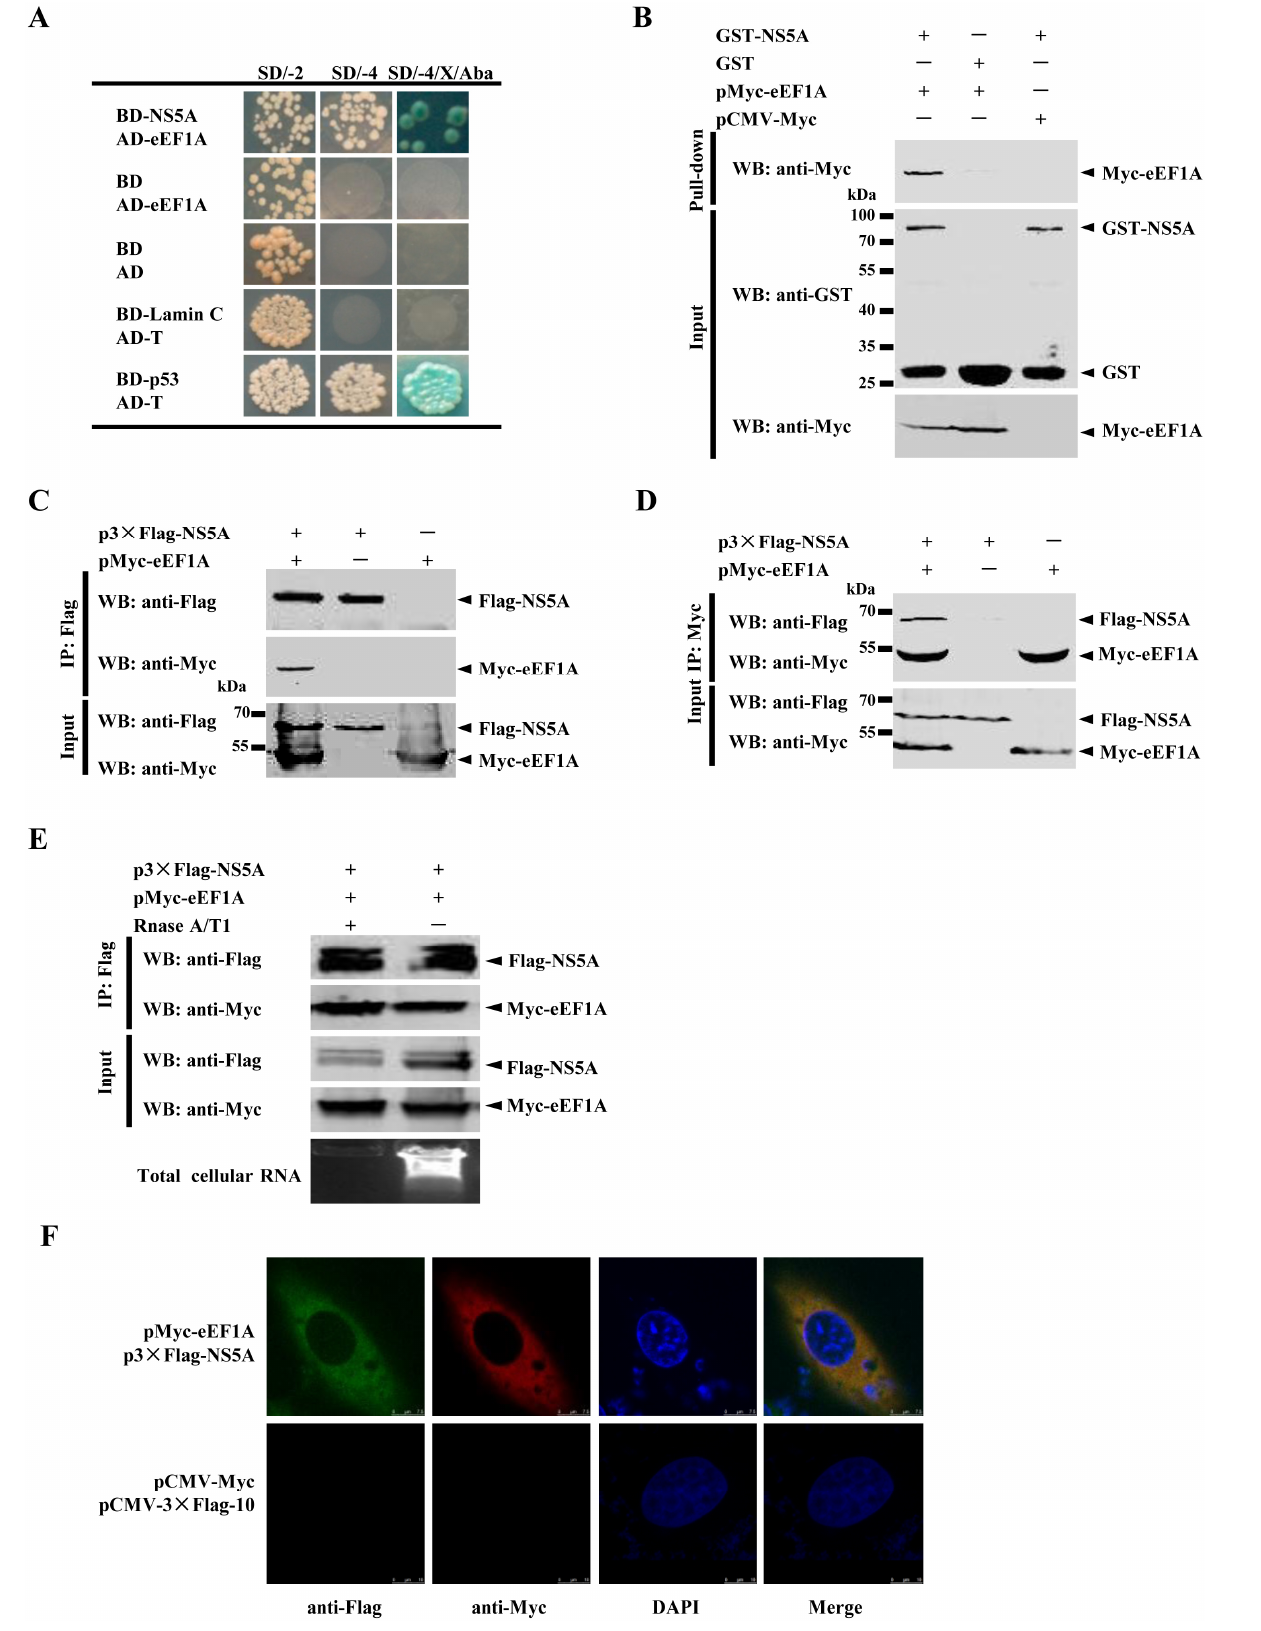
Figure 1. Interaction of NS5A and eEF1A. ( A ) Reactivity of NS5A with eEF1A in a yeast two-hybrid (Y2H) system. Yeast Y2HGold strain was cotransformed with pGBKT7-NS5A